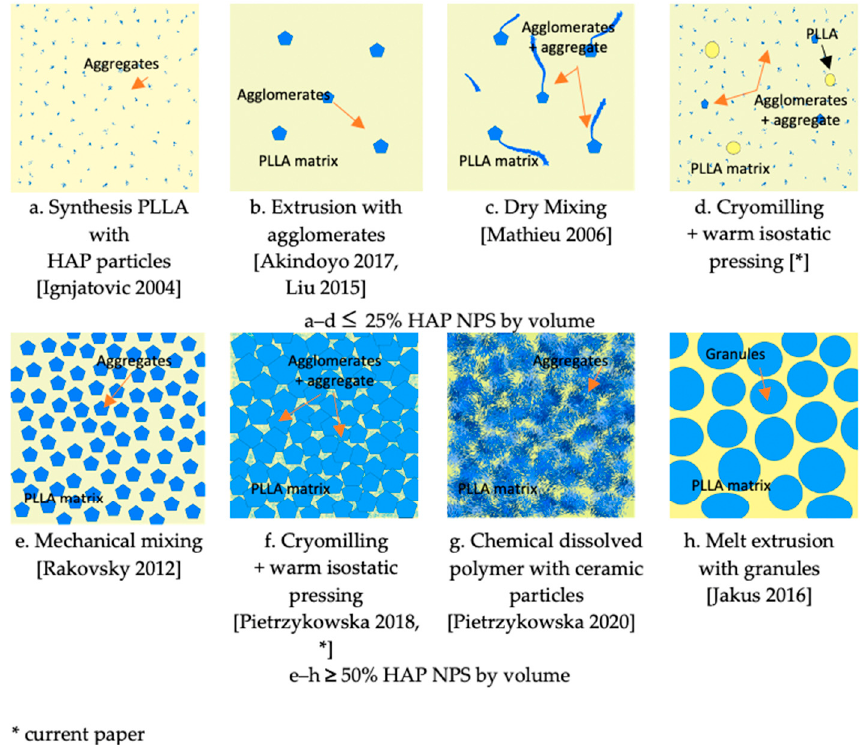
Figure 10. Schematic structures of composites based on bioresorbable polymers depending on calcium phosphate quantity and method of obtaining.